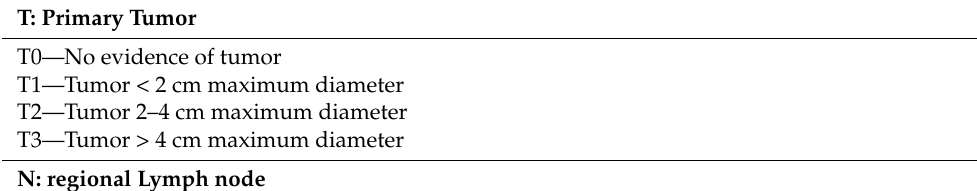
Table 1. Adapted from World Health Organization (WHO) primary tumor, regional lymph